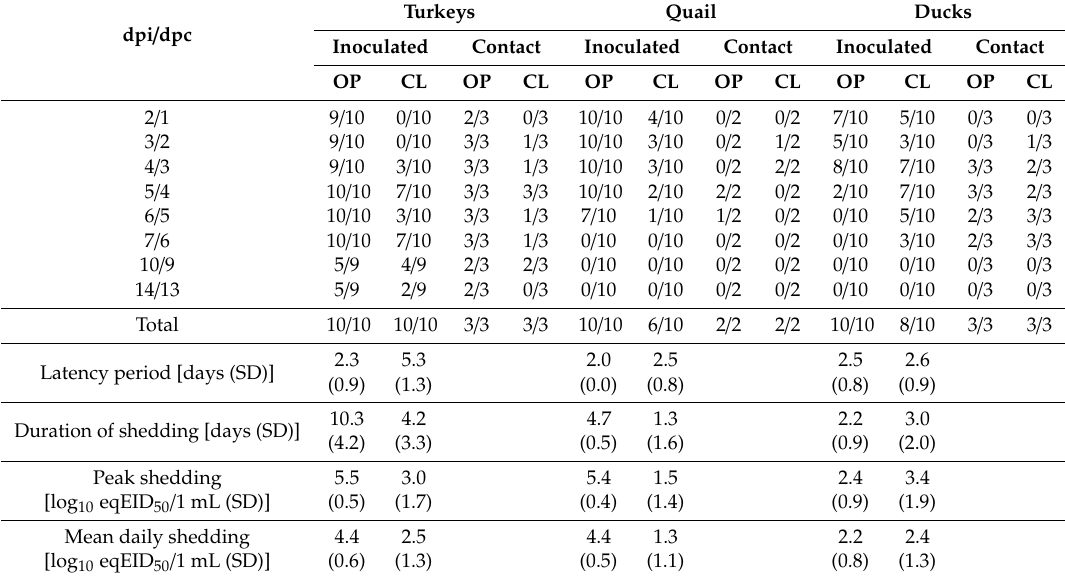
Table 1. Shedding patterns in turkeys, quail and ducks infected with A / turkey / Poland / 14 / 2013(H9N2). The number of swabs positive for viral RNA over the total number of swabs tested is presented. OP – oropharyngeal swabs, CL – cloacal swabs, SD – standard deviation. dpi / dpc